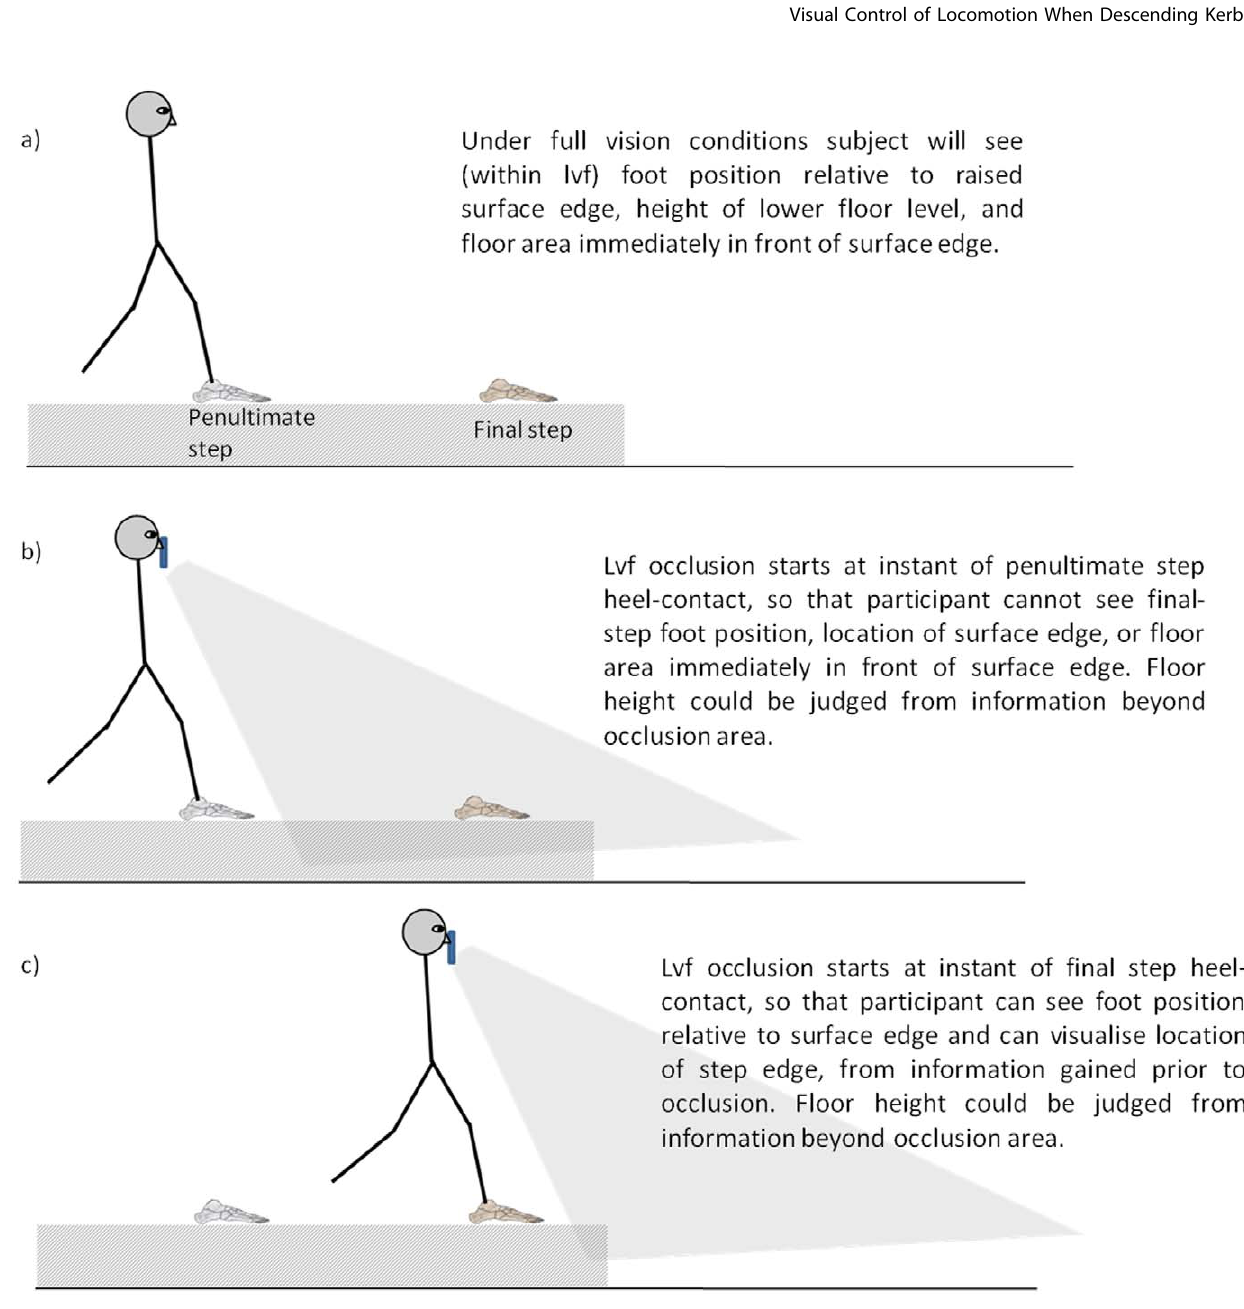
Figure 4. The three visual conditions.